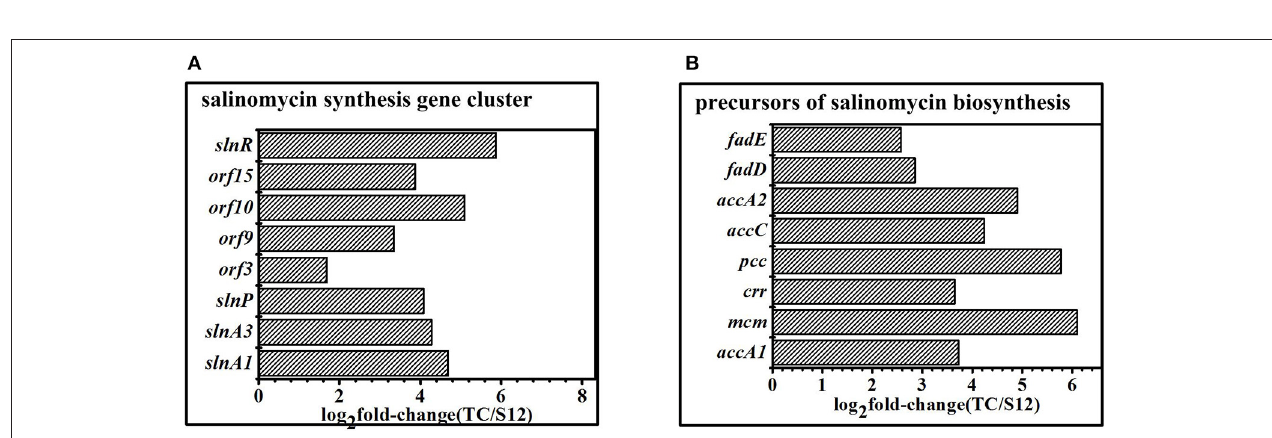
FIGURE 5 | GO function enrichment analysis of genes from the cluster 7. P -value represents the level of signifiance, and treated by –log 2 , the smaller the p -value, the larger –log 2 P, and the better the significance. Red column means correlation is significant, blue column means not significant.